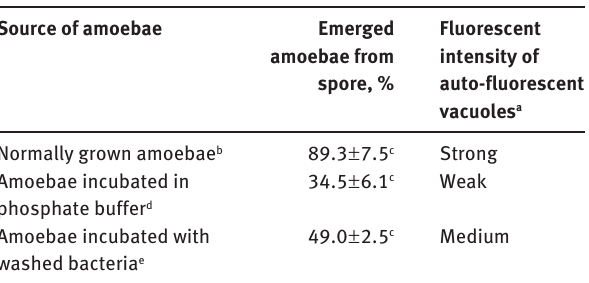
Table 1 Germination activity of the UV-C-irradiated (1440 J/m 2 ) spore mass.